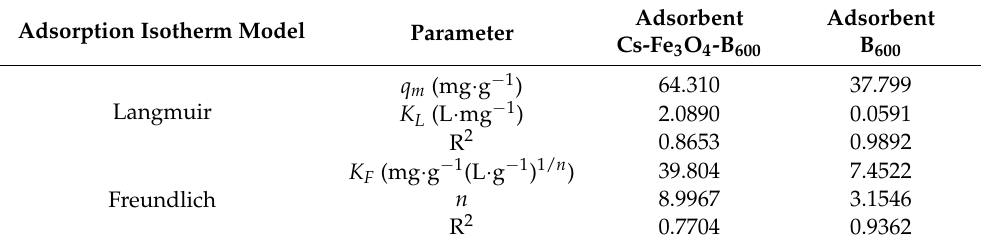
Table 2. Langmuir and Freundlich isotherm models for Cd(II) adsorption on Cs-Fe 3 O 4 -B 600 and B 600 . Adsorption Isotherm